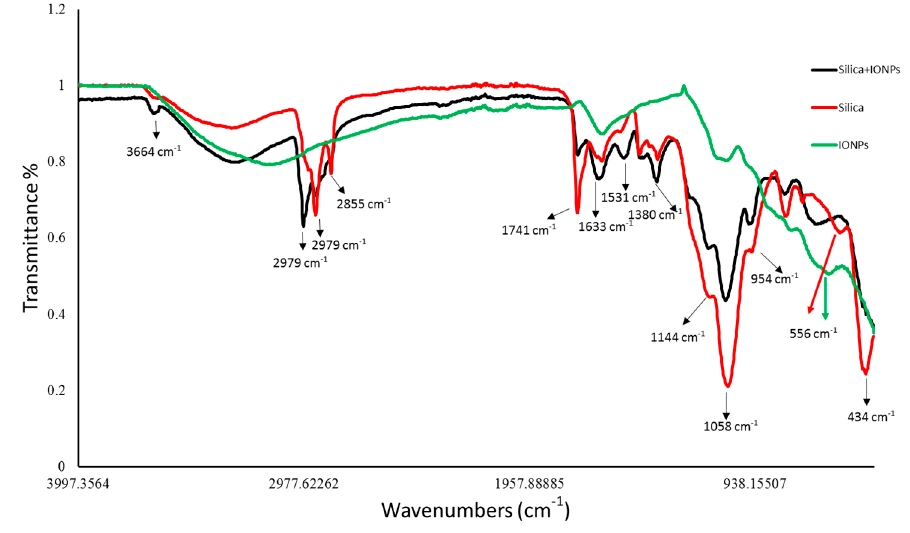
Figure 4. FTIR peaks revealed the functional groups present surrounding the surfaces of control silica, silica loaded particles and extracellular IONPs.